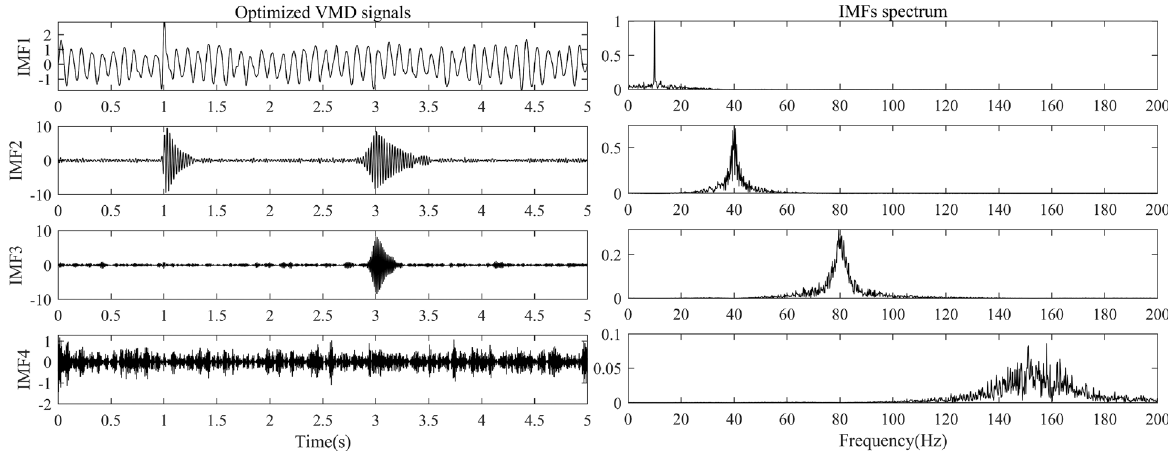
Figure 6 Optimized VMD signals and their frequency